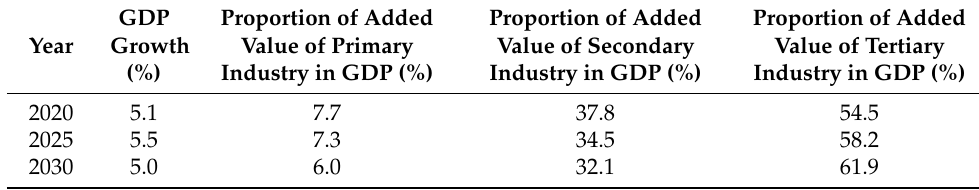
Table 3. The prediction of GDP growth rate in China.